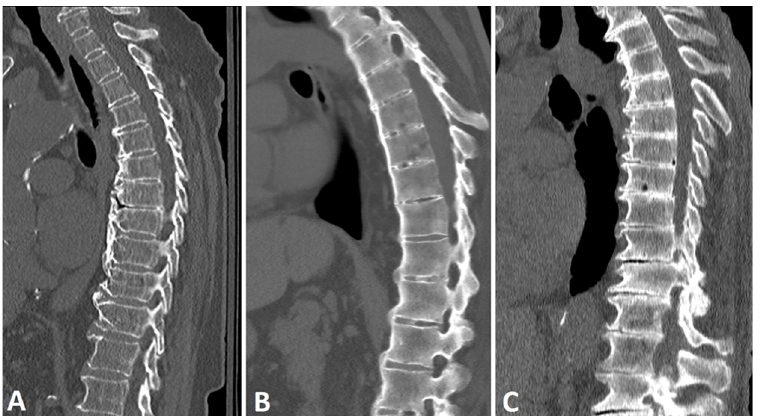
Figure 1. Sagittal CT reconstructions of the thoracic spine in three different patients: ( A ) a patient with DISH with thick, flowing, horizontally oriented, coarse osteophytes; ( B ) a patient with AS with slender, vertically oriented syndesmophytes; and ( C ) a patient with degenerative disc disease with horizontally oriented, non-flowing osteophytes. Note that the disc space is relatively preserved in the DISH subject, but not in the patient with a degenerative spine.